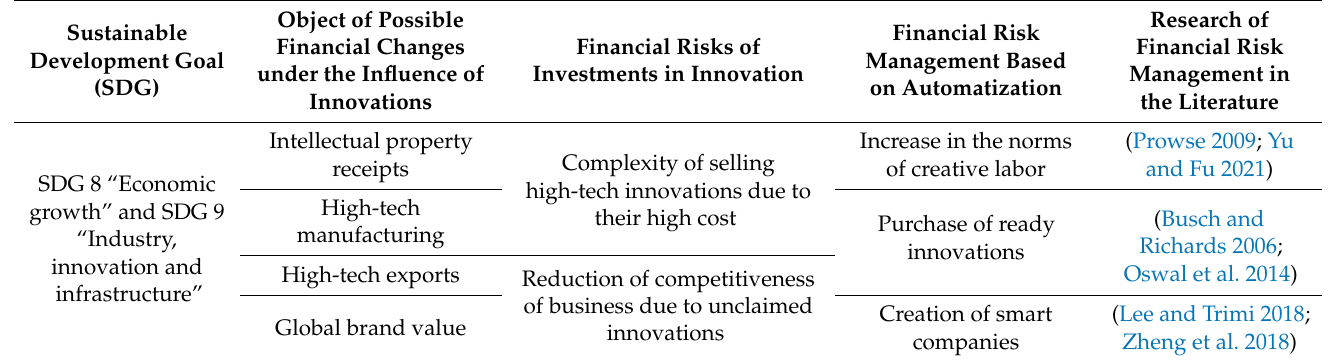
Table 2. Financial risks of managing the investments in innovation and the approach to this manage-